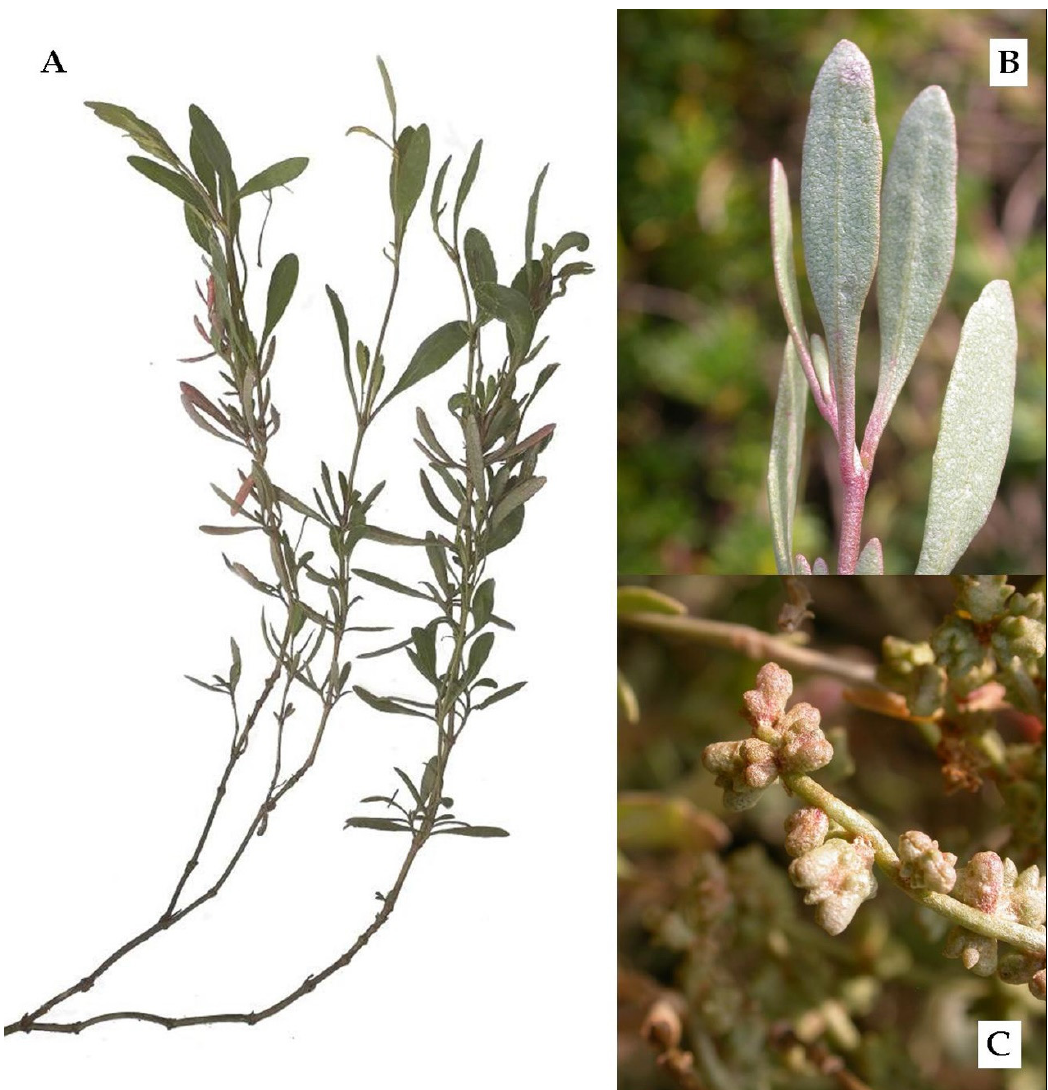
Figure 1. Morphology of A. portulacoides : ( a ) branching and decumbent habit; ( b ) leaf close up; ( c ) freshly formed fruits in autumn.